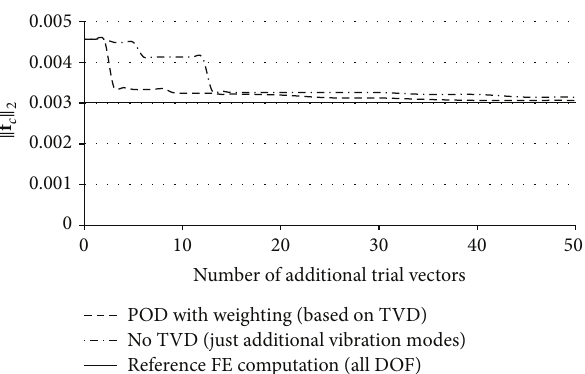
Figure 14: Visualization of the first six columns of